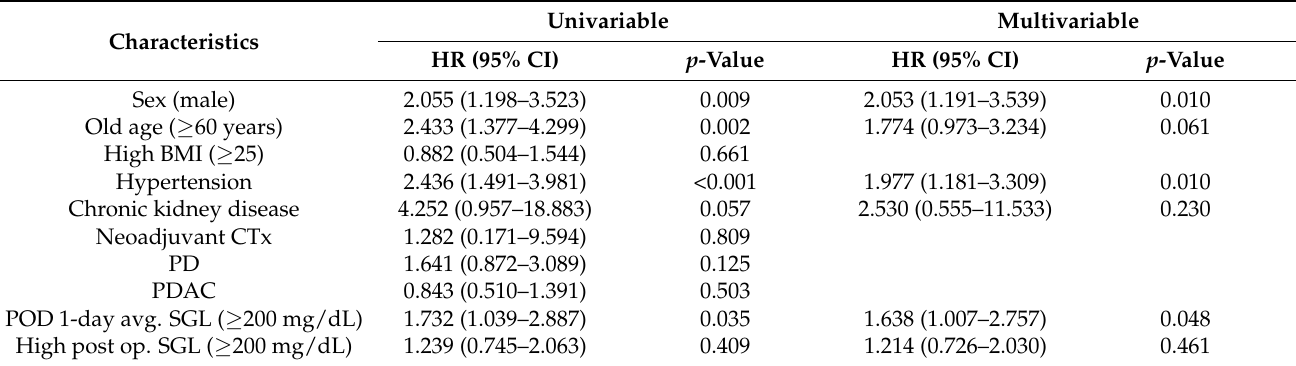
Table 4. Logistic regression for risk factor analysis of re-operation.